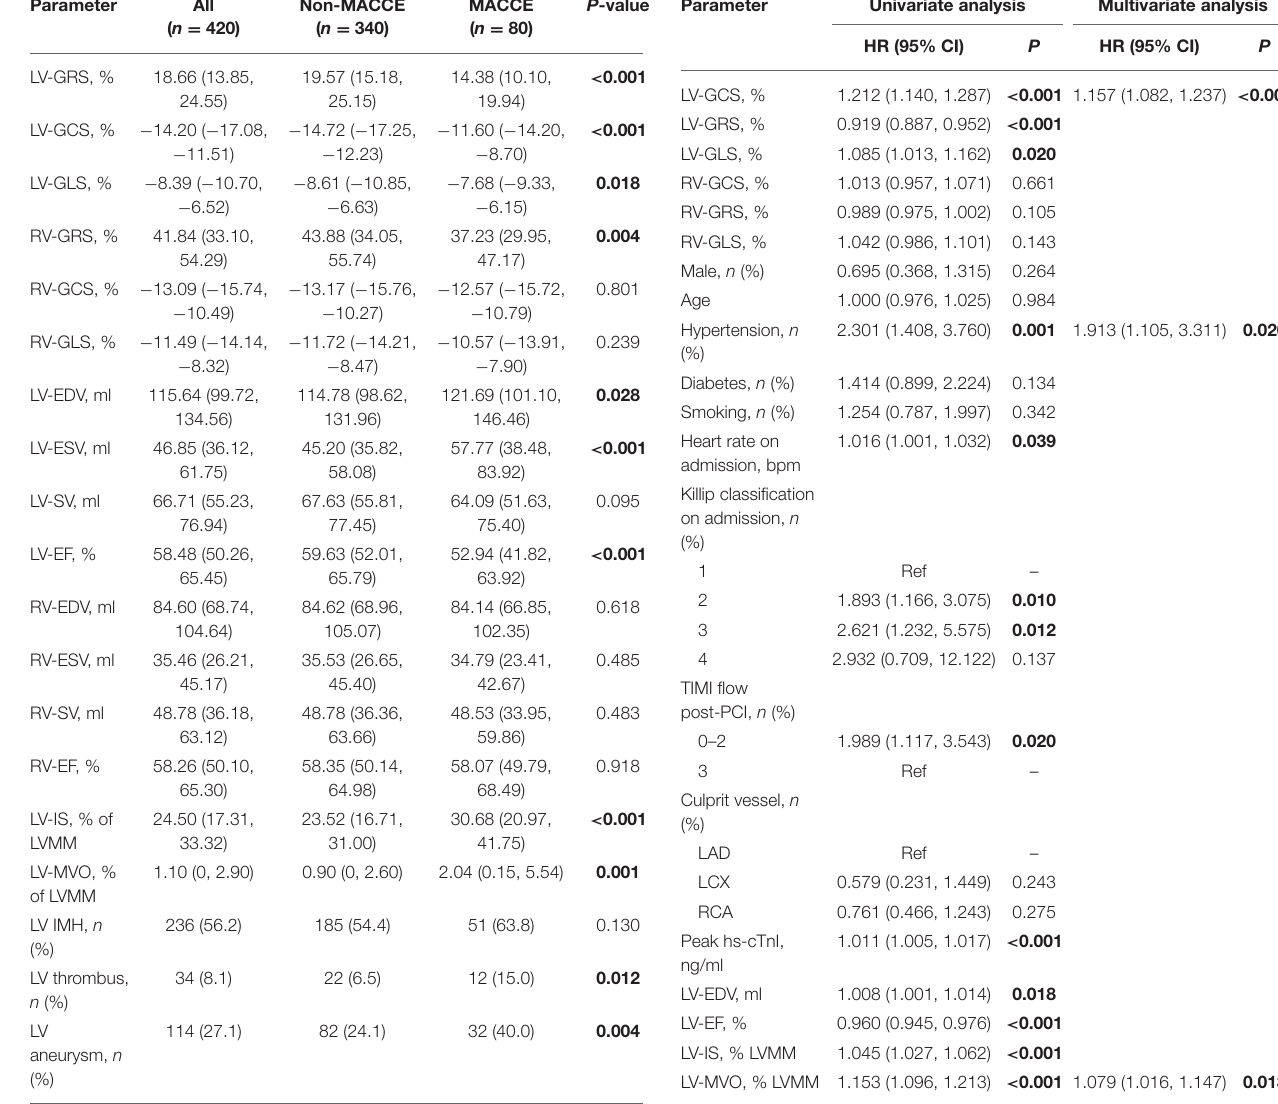
TABLE 2 | CMR indexes of patients with STEMI. TABLE 3 | Cox regression analysis of predictors for